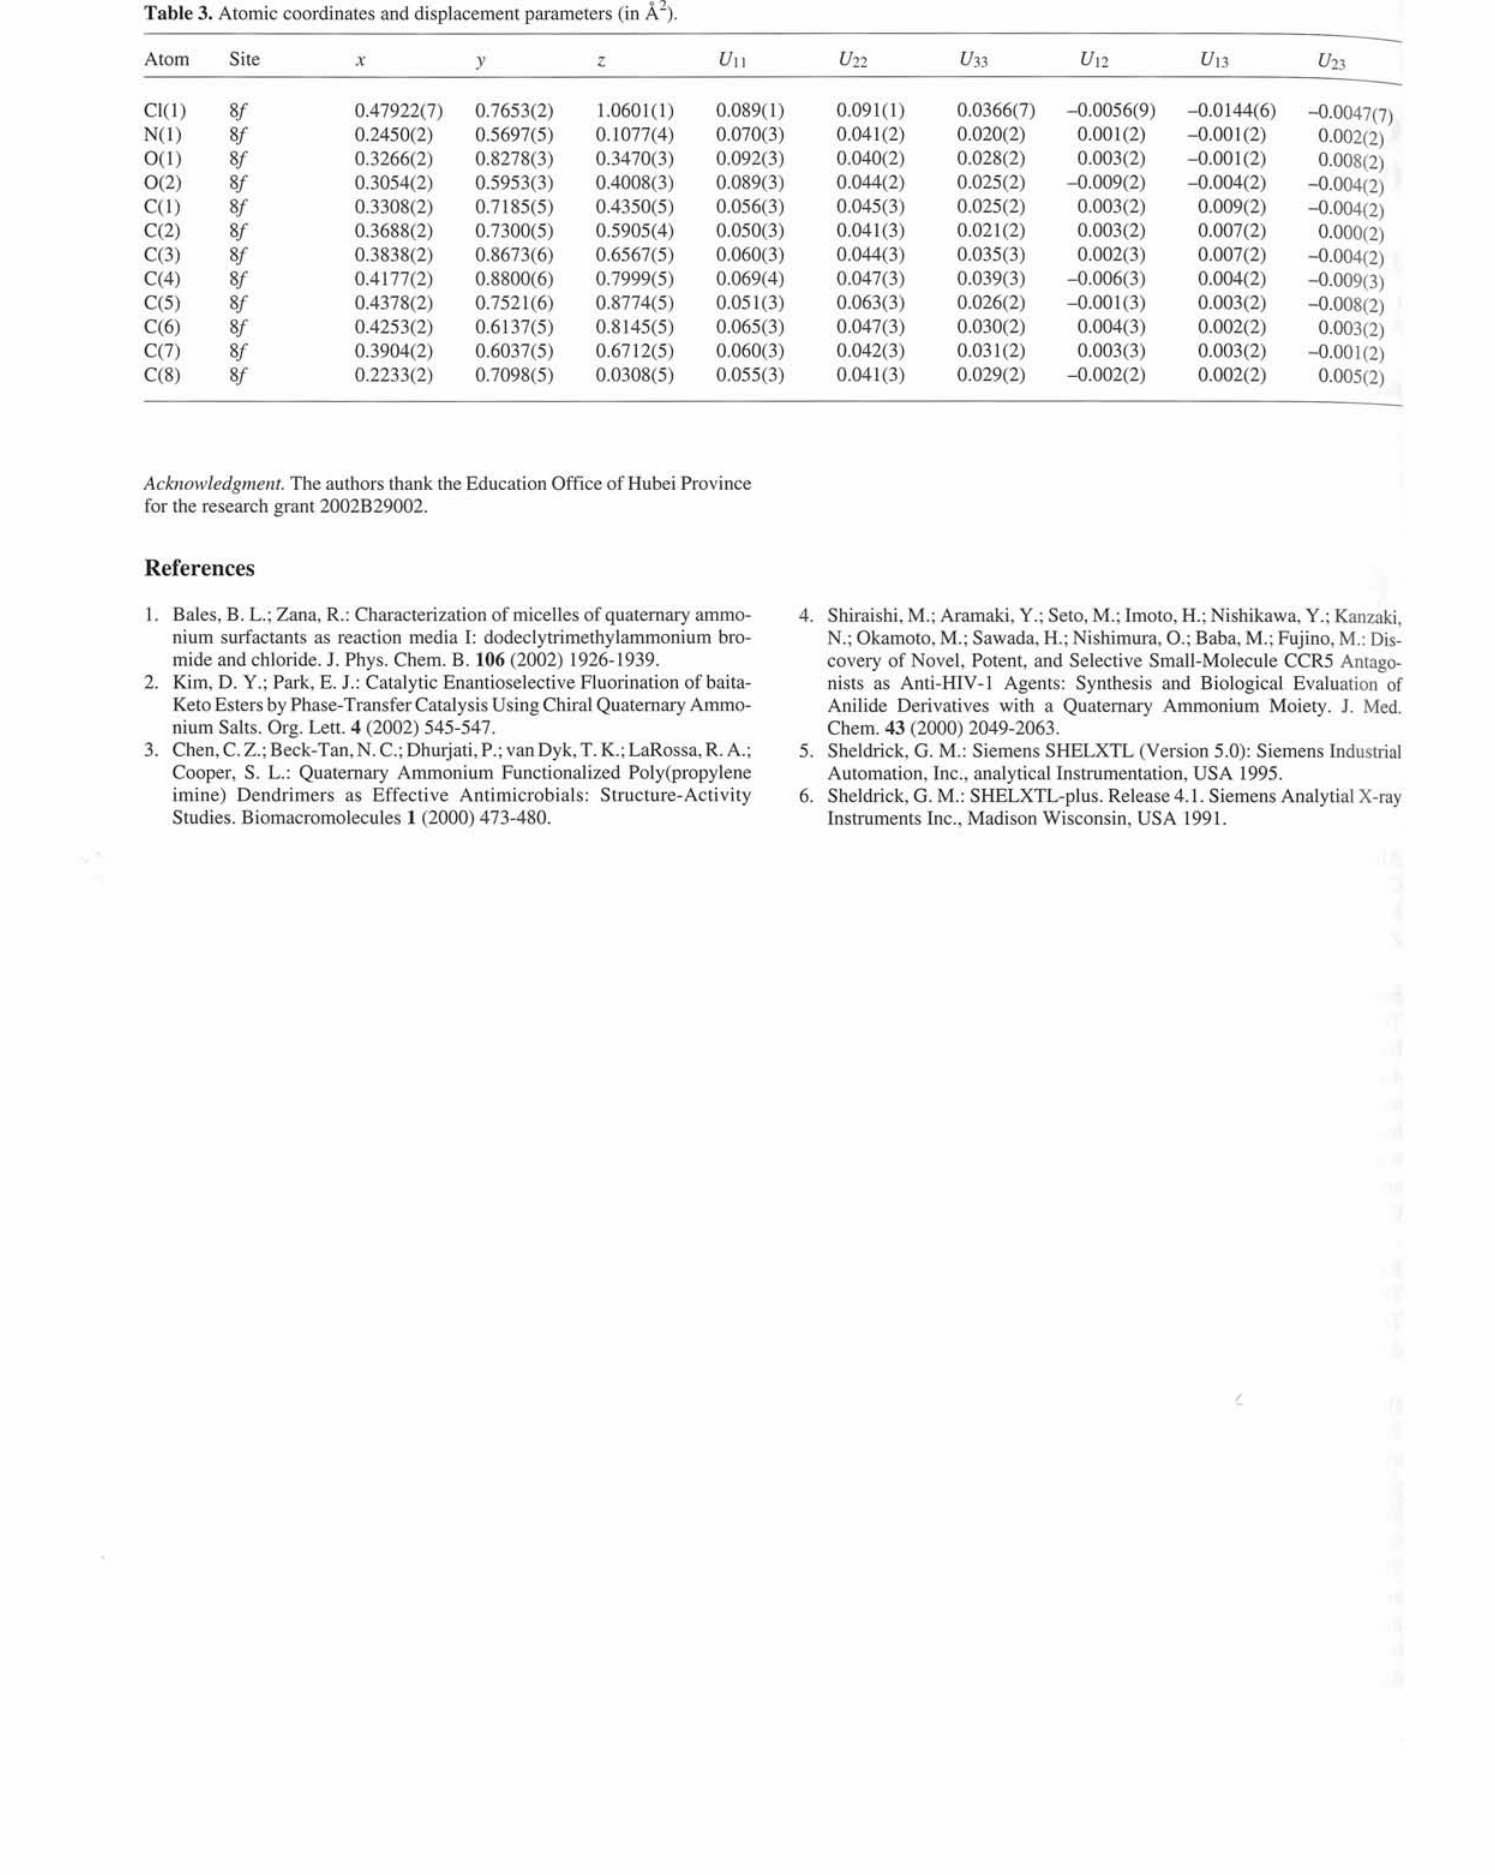
Table 3. Atomic coordinates and displacement parameters (in À 2